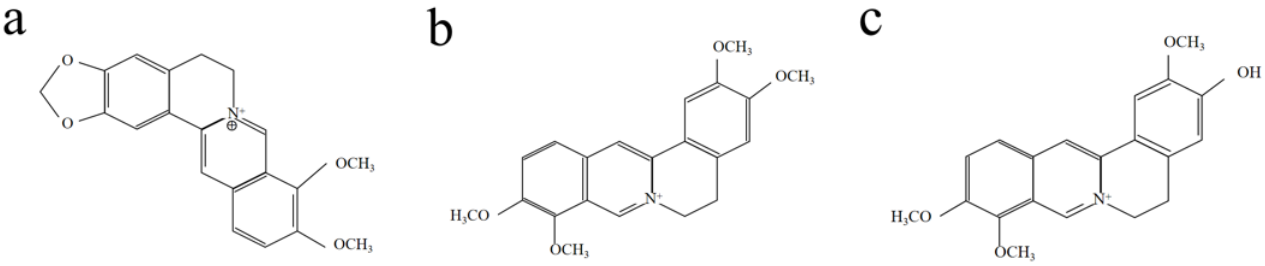
Figure 1. Chemical structure of the main dye compounds in P. amurense : ( a ) berberine, ( b ) palmatine, ( c ) jatrorrhizine.